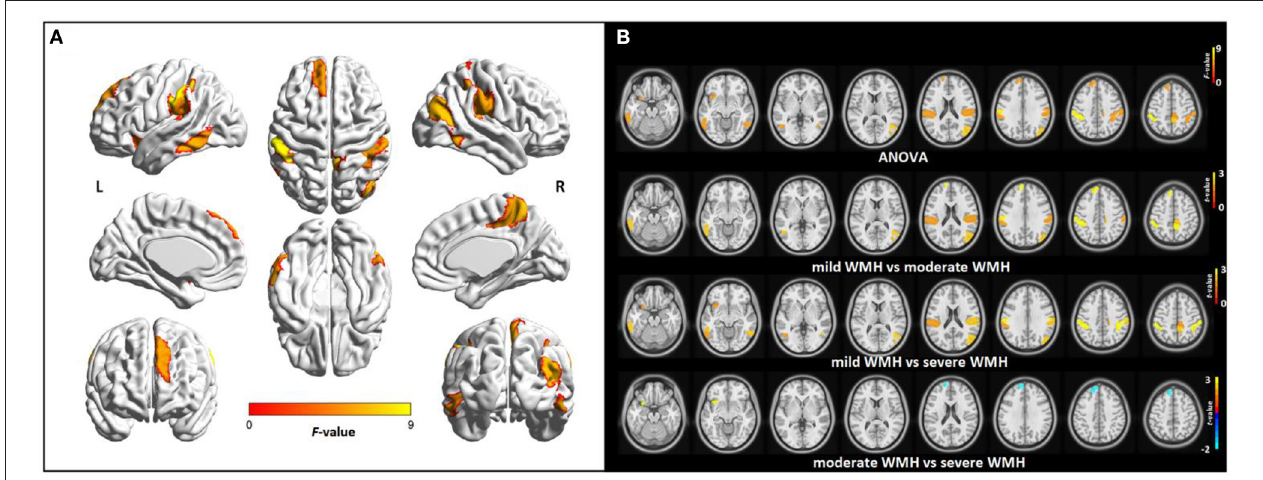
FIGURE 3 | Group differences in regional FCS among subjects with different WMH loads controlling for age and sex. (A) Surface statistical maps displaying F -scores of ANOVA for altered FCS among three groups ( p < 0.01, with permutation test for 1,000 times). (B) Axial statistical maps displaying F -scores of ANOVA and t -scores of post-hoc analysis between every two groups. In statistical maps of ANOVA, warmer colors indicate significant differences in regional FCS among three groups. In statistical maps of post-hoc analysis between every two groups, warm colors represent regional FCS decrease in moderate WMH group compared with mild WMH group, or in severe WMH group compared with mild WMH group, or in WMH3 group compared with moderate WMH group, respectively, and cold colors represent regional FCS increase in severe WMH group compared with moderate WMH group. No significant increased FCS was found in severe WMH group relative to mild WMH group, or moderate WMH group when compared with mild WMH group. L, left; R,